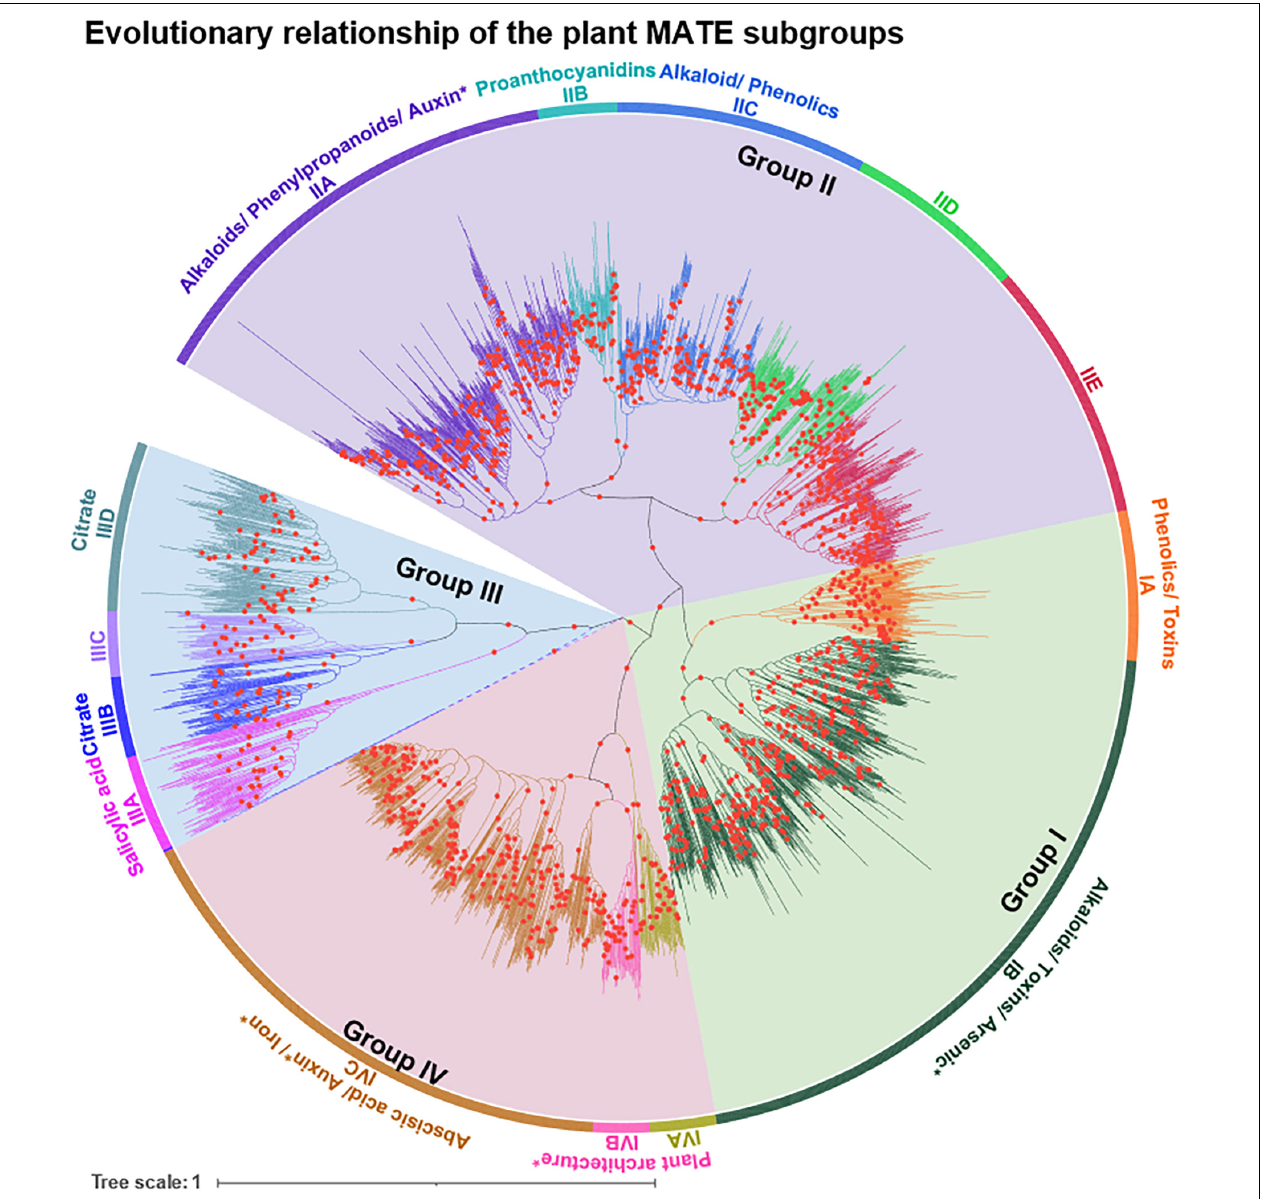
FIGURE 3 | Evolutionary relationship of MATE subgroups in the plant kingdom. By applying ≥ 60% full-length protein sequence identity (PSI) threshold using USEARCH, subgroups were identified for 3,369 MATEs (termed as USEARCH-classified MATEs). USEARCH was employed with a minimum linkage option, meaning that members in each subgroup share ≥ 60% PSI with any single member in the same subgroup. An unrooted neighbor-joining phylogenetic tree was constructed with the trimmed multiple sequence alignment of USEARCH-classified MATEs having 388 amino acid positions. Groups I–IV were designated according to Wang et al. (2016), and subgroups were designated based on their clockwise appearance within each group in the tree. Groups and subgroups are distinguished by different background and branch colors, respectively. All members are clustered according to their subgroup assignment except two, for which branches are indicated by dashes. The functional information of MATE substrates are shown based on Supplementary Table 5 . The phylogeny was constructed with 1,000 bootstrap replications in MEGA X and is colored/annotated using iTOL. Bootstrap support values of ≥ 70% were indicated by red circles on tree branches. “*” Exact substrates are not